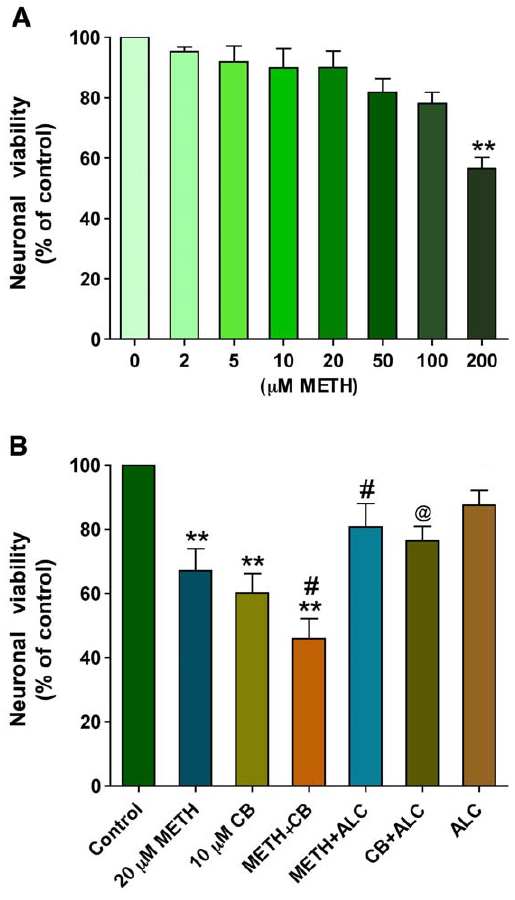
Figure 1. Effect of METH-induced glucose deprivation on neuronal viability: A. Dose dependent effects of METH on cell viability in human neurons at 24 hr. B. Cell viability assay of human neurons treated with 20 m M METH in presence or absence of cytochalasin B (10 m M) or ALC (100 m M) for 72 hr. Statistically significant (n=5), **p , 0.01 compared with controls in A and B ; # P , 0.05 with 20 m M METH in B ; and @ p , 0.05 with 10 m M cytochalasin B in B .